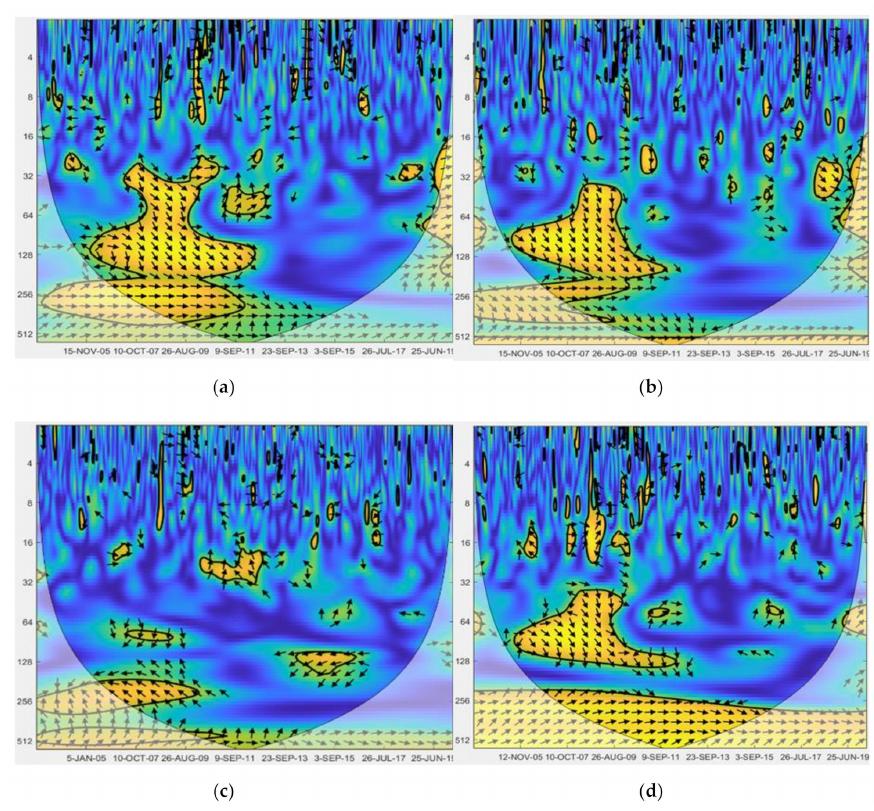
Figure A3. The co-movement between WTI crude oil and stock markets in time-frequency space in the context of panic. ( a ) US stock market, SP500; ( b ) Japanese stock market, N225; ( c ) mainland China’s stock market, SSEC; ( d ) Hong Kong stock market,